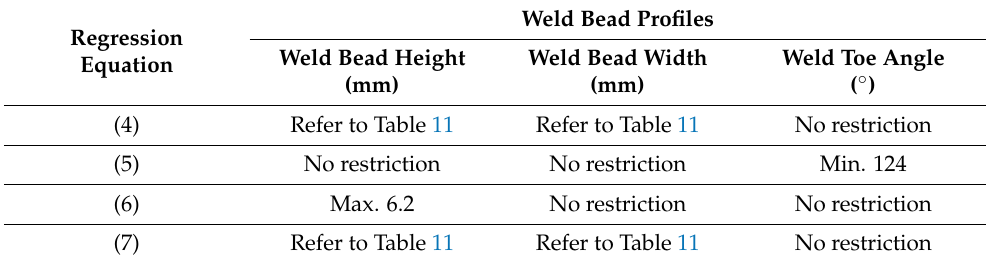
Table 10. The regression equations for the conditions that the angular distortion is 0.7 ◦ and the required S-N curve is the E curve of the BV rule. The data was from Ref. [26]. Regression